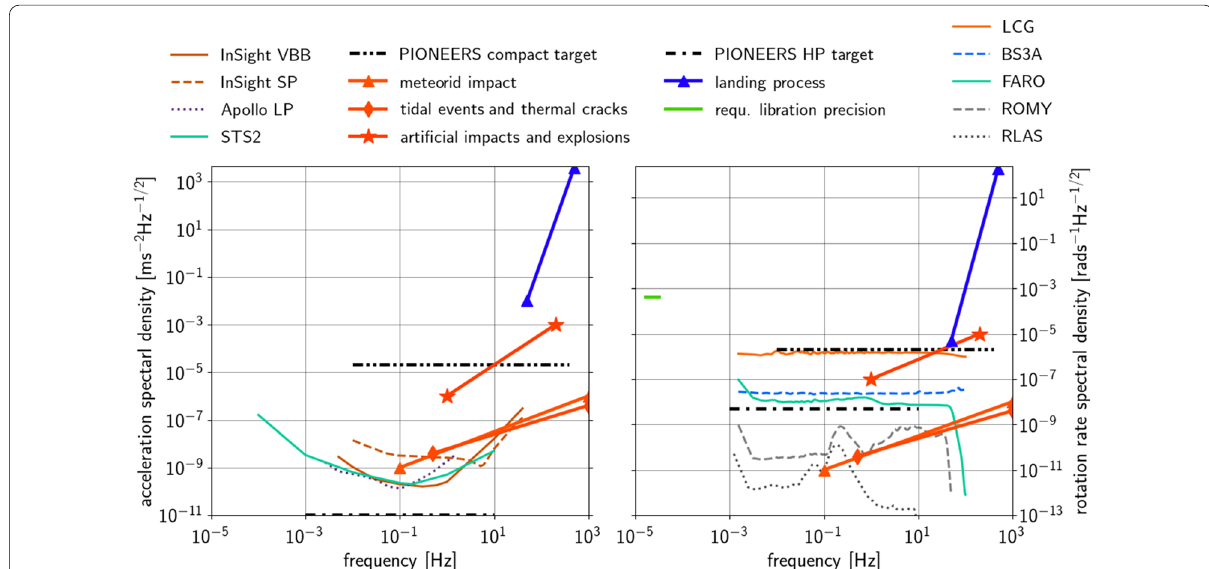
Fig. 5 Expected signal levels on Dimorphos. For forced librations, the required resolution is shown. Additionally, self‑noise levels of commonly used sensors are shown: Left panel: Very broad band (VBB) sensor and short‑period (SP) sensor on the InSight mission (Lognonné et al. 2019), the long‑period (LP) instrument from the Apollo mission (Nunn et al. 2020), and an STS2 (Sleeman and Melichar 2012). Right panel: LCG‑Demonstrator from Litef, Germany (Bernauer et al. 2012), BlueSeis3A from iXblue, France (Bernauer et al. 2018), and the giant fiber‑optic gyroscope FARO (by